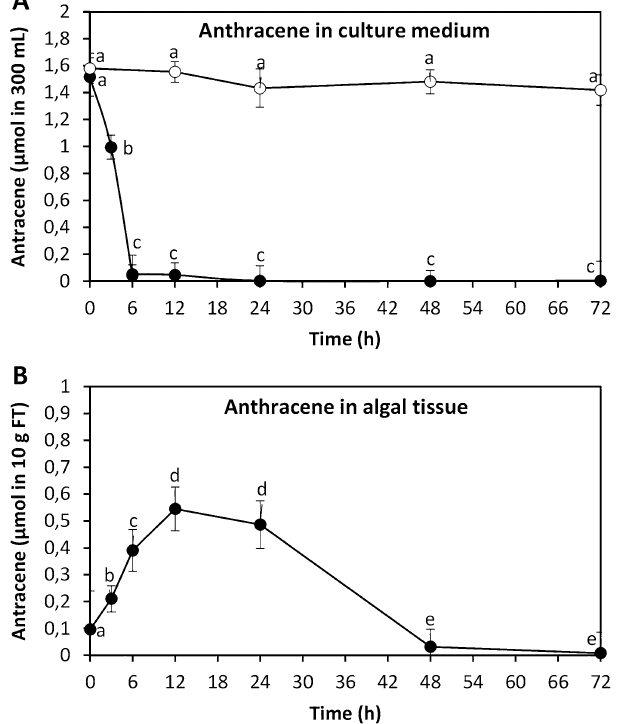
Figure 2. Level of anthracene (ANT) in the culture medium ( A ) and in U. lactuca ( B ) cultivated with 1.6 μmol of ANT in 300 mL of culture medium (5 μM) for 0–72. Black circles represent the level of ANT in the culture with ANT and open circles represent the level of ANT in the culture medium with ANT but without the alga. Symbols represent mean values of three independent experiments ± SD. Letters indicate significant differences among experiments ( P <